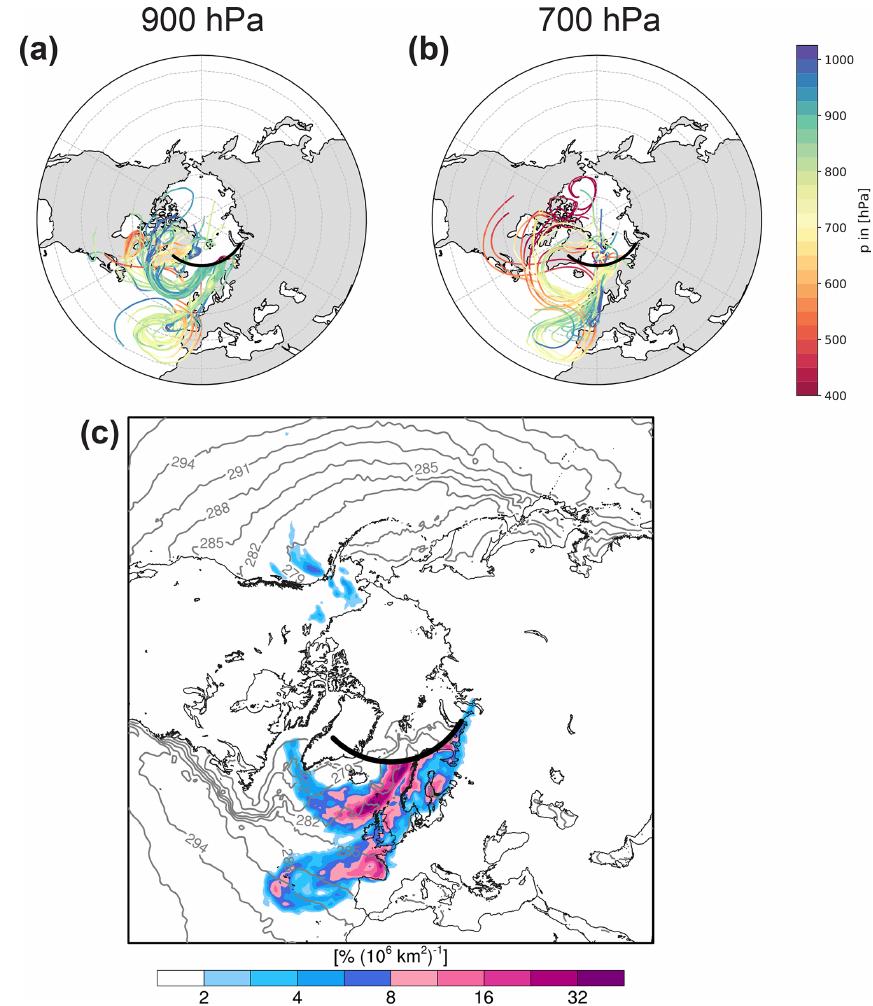
Figure 1. Exemplar case of a moist-air intrusion in the North Atlantic on 17 January 1995. Shown in panels (a) and (b) are the 8d kinematic backward trajectories colored according to pressure and initialized at 70 ◦ N (black solid line) in the pressure ranges of (a) 895–905hPa and (b) 695–705hPa. Shown in panel (c) is moisture uptake per area in percent of the total moisture transported across 70 ◦ N by the trajectories. Gray contours show SST in intervals of